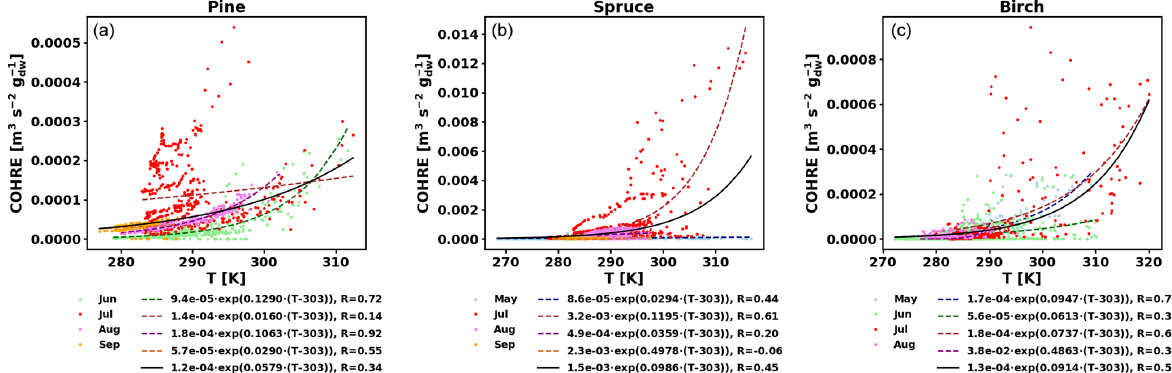
Figure E1. COHRE temperature dependence by month (coloured dots and dotted line fits) and fit for all data combined (black solid line) for pine (a) , spruce (b) , and birch (c) .